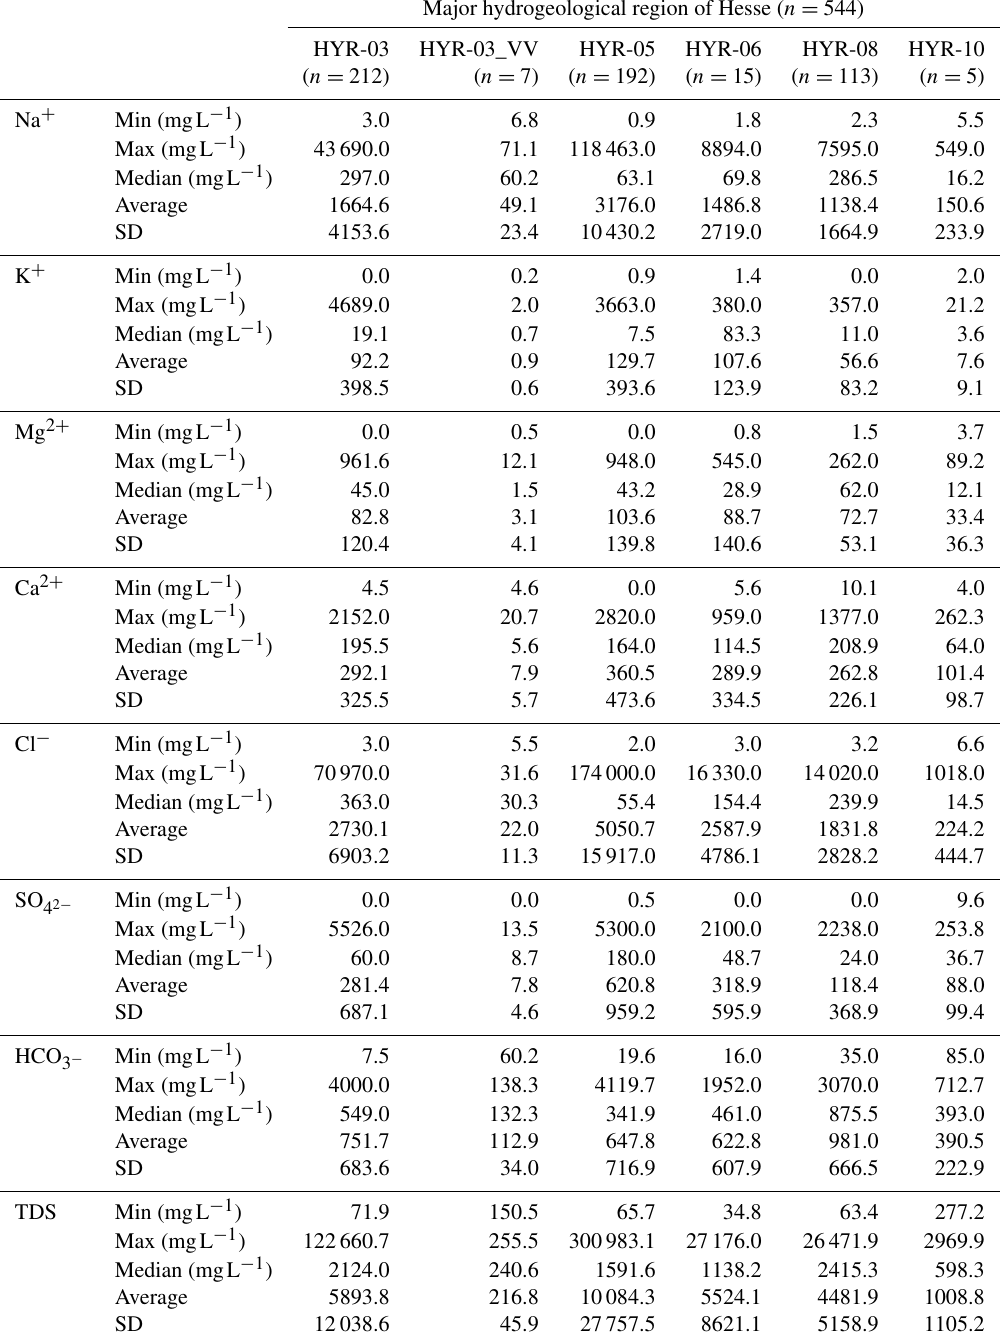
Table 3. Specific statistical values of major ions and TDS separately listed for the individual hydrogeological regions of